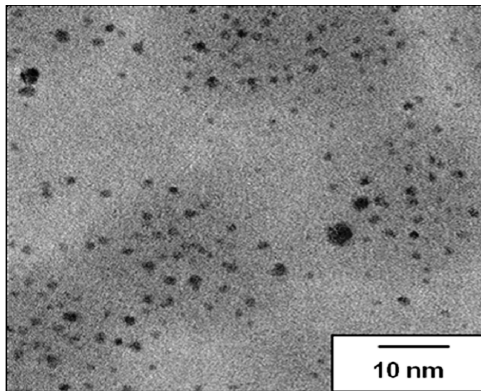
Figure 1. Transmission electron micrograph of silver nanocomposite, stabilized with XG, showing spherical-shape nanoparticles in the polymer.